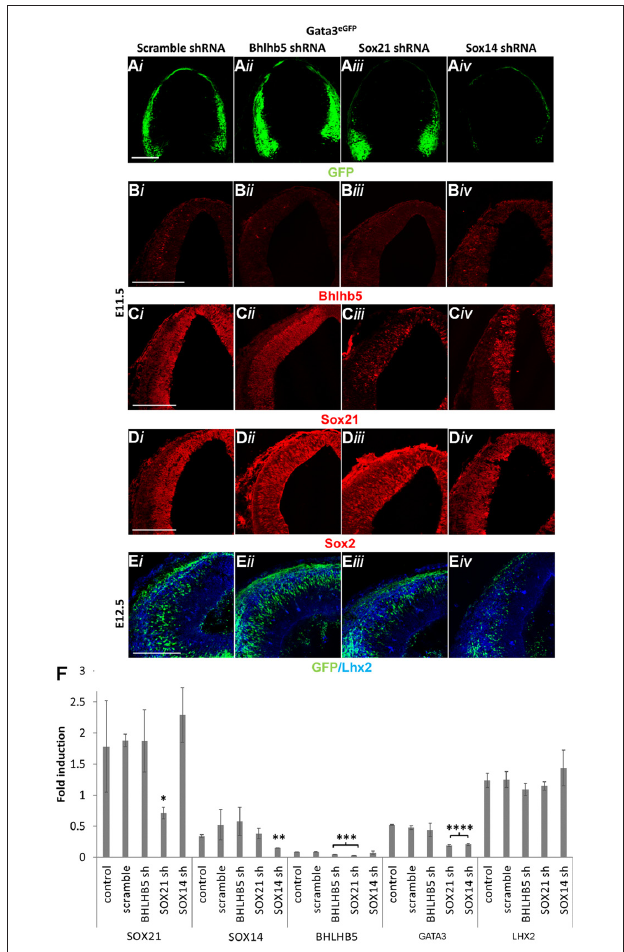
FIGURE 8 | Lentiviral knock down of SOX21, SOX14 and BHLHB5. GATA3 eGFP embryos were infected through intra amniotic injections at E8.5 with lentiviral shRNA vectors targeting BHLHB5 (PLKO.1-shBHLHB5; ii ), SOX21 (PLKO.1-shSOX21; iii ) and SOX14 (PLKO.1-shSOX14; iv ). The expression of GFP was reduced in the embryos infected with the SOX14 shRNA vector (A,E) . Immunostaining of the embryos with BHLHB5 showed a reduction when embryos were infected with PLKO.1-shBHLHB5 and PLKO.1-shSOX21 (B) . Not surprisingly, SOX21 was only reduced when embryos were infected with PLKO.1-shSOX21 (C) while not noticeable changes were observed in the expression of SOX2 (D) and LHX2 (E) when infected with either vector. These data were confirmed by RT-Q-PCR analysis of embryos at E12.5 (F) . Data are represented as mean ± SEM. ∗ n = 6 (3 pairs of mice), SOX21sh p = 0.0417, DF = 4, Kruskal Wallis test, ∗∗ n = 6 (3 pairs of mice), SOX14sh p = 0.0141, DF = 4, Kruskal Wallis test, ∗∗∗ n = 6 (3 pairs of mice), SOX21sh p = 0.016, BHLHB5sh p = 0.0474, DF = 4, Kruskal Wallis test, ∗∗∗∗ n = 6 (3 pairs of mice), SOX21sh p = 0.0064, SOX14sh p = 0.0021, DF = 4, Kruskal Wallis test. Scale bar, 150 µ